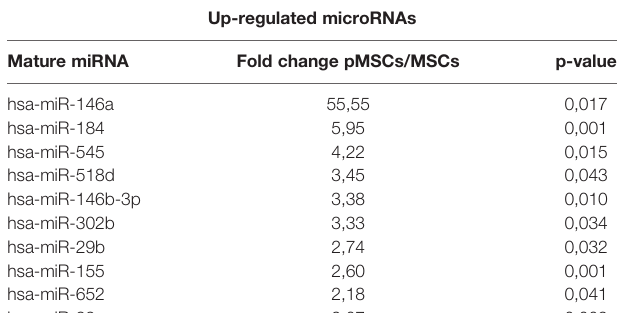
TABLE 1 | List of miRNAs modulated in